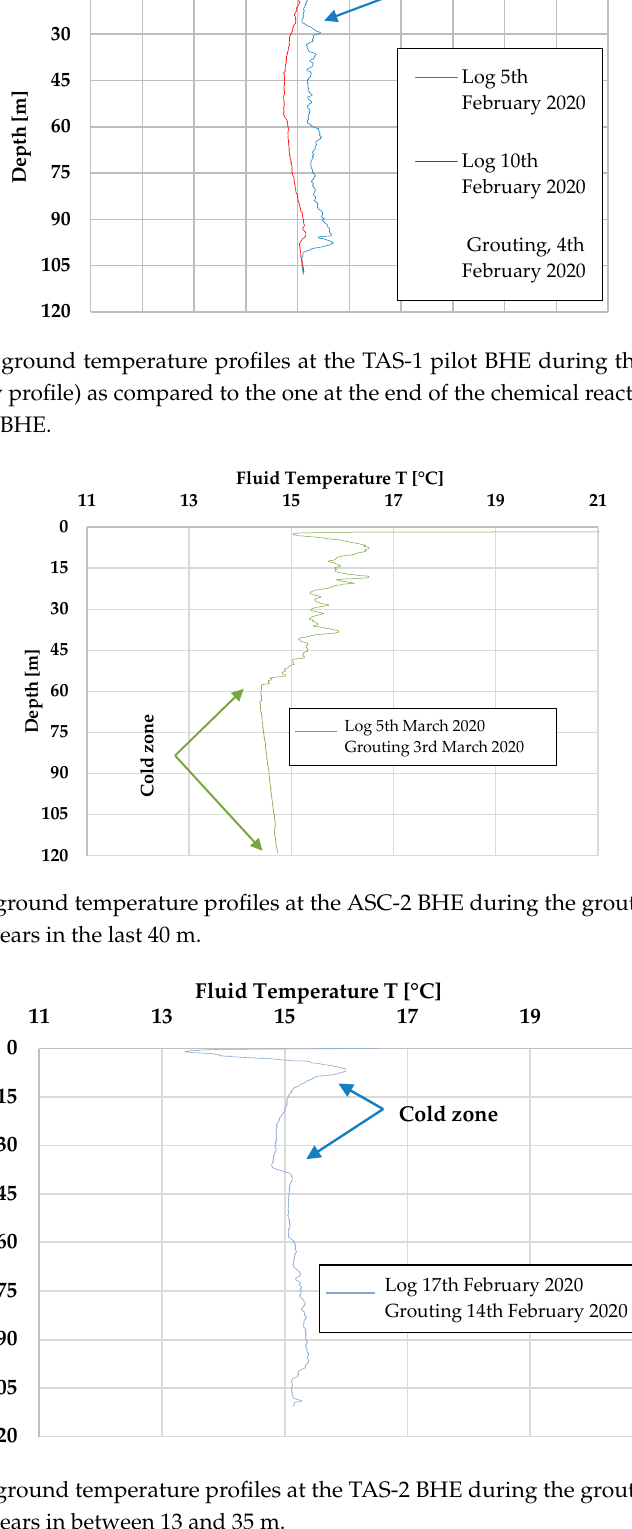
Figure 9. Vertical ground temperature profiles at the TAS-2 BHE during the grout hydration period. A “cold zone” appears in between 13 and 35 m. Columns A and B represent the slope m and intercept a of the ILS fitting line (Equation (6)), respectively. Furthermore, columns k gr and R bhe provide estimates of the corresponding quantities at the given depth. Finally, the last row of Table 1 shows the averages of each column.